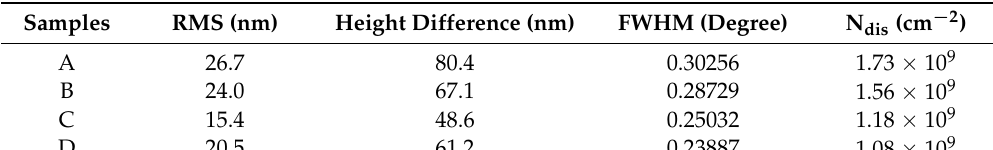
Table 1. Variation of the root-mean-square (RMS) roughness, height difference, the full width at half maximum (FWHM), and dislocation density of the four samples.